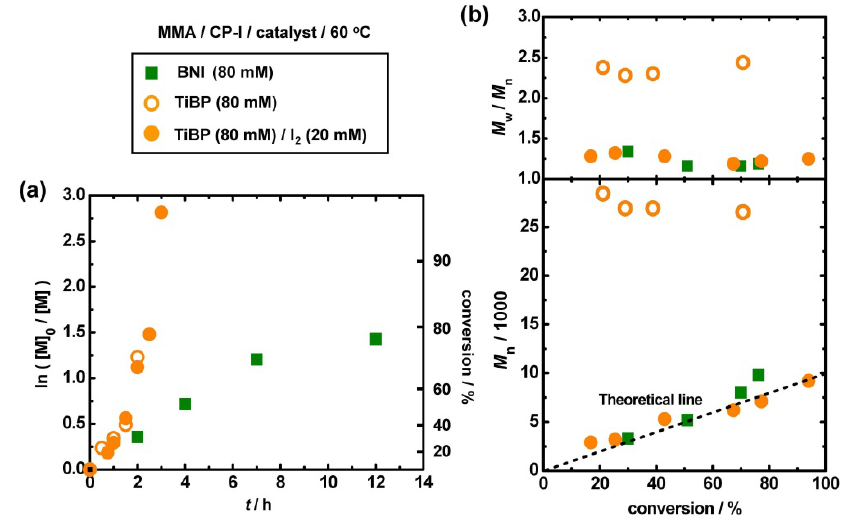
/[M]) vs. t and ( b ) M 0